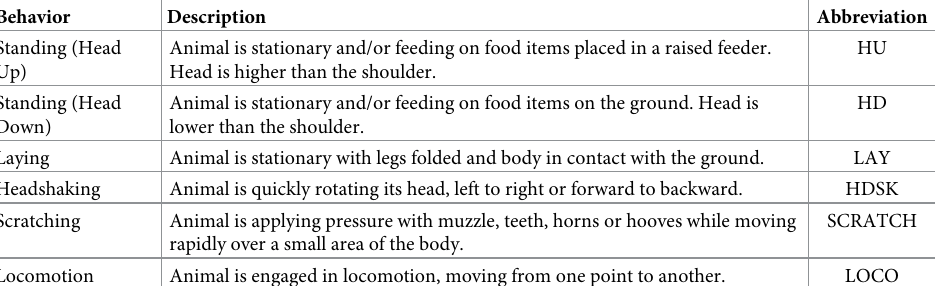
Table 2. Response descriptions, derived from Packard et al. (2014), to evaluate behavioral changes related to GPS collar fitting. Behavior tallies collected every 15 seconds during 10-minute observation